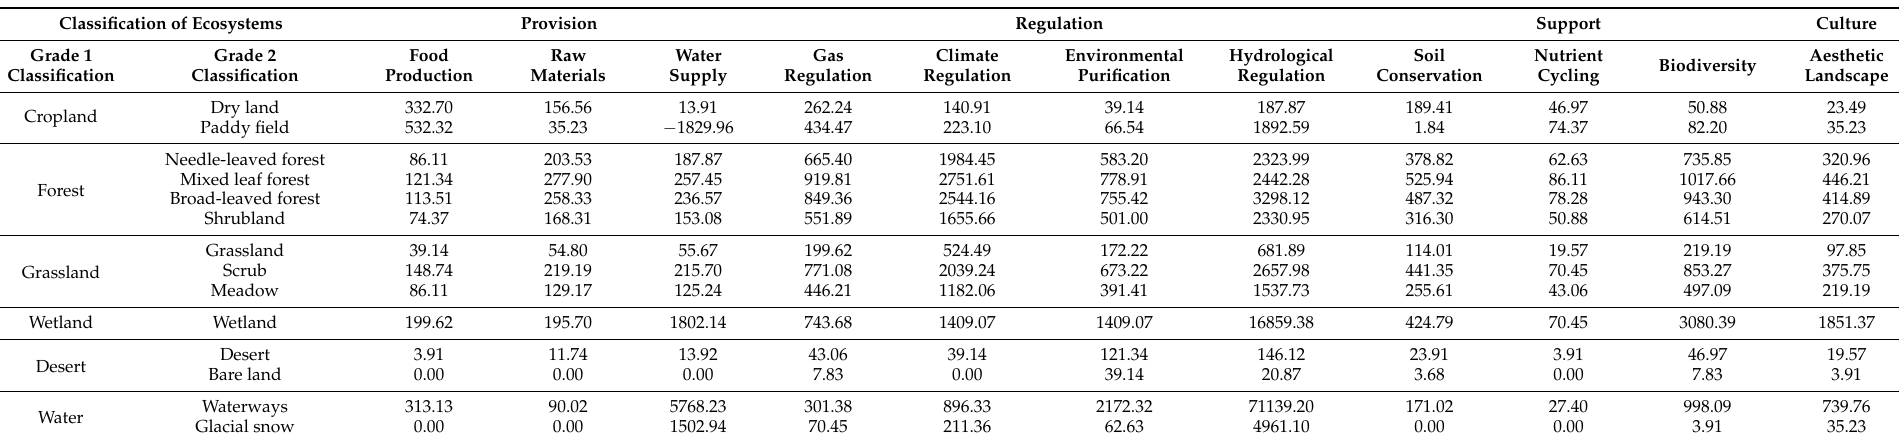
Table 4. ESV coefficient per unit area in Nanjing. Unit: